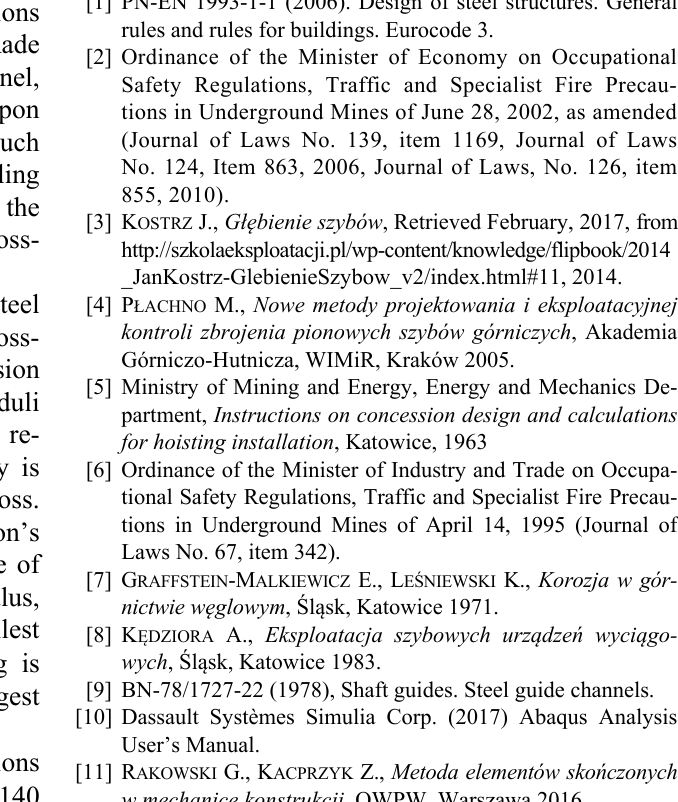
guide profile. Local bucking was indicated for profiles of 65% corrosion loss